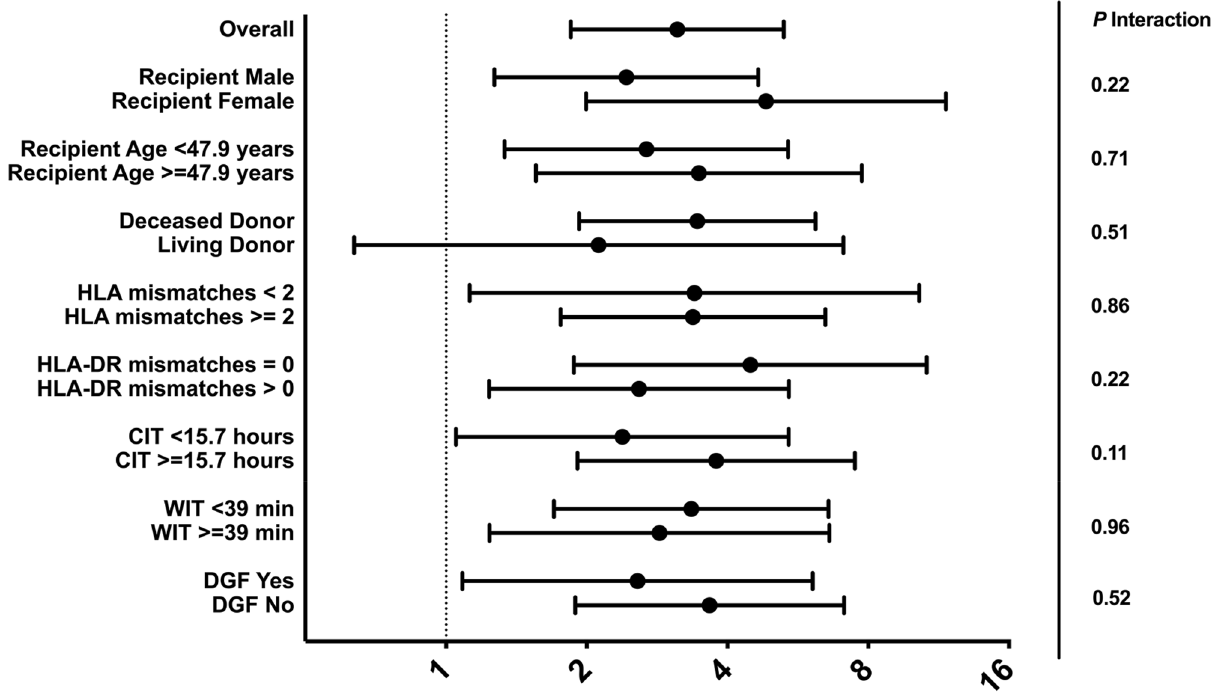
Figure 5. Hazard ratios for the IL-6/IL-6R genetic risk score among subgroups. Forest plot of sub-analyses of the IL-6/IL-6R genetic risk score, demonstrating that the hazard ratios for biopsy-proven rejection were consistent in different subgroups. The only exception was the donor origins of the kidney allografts. The association between the IL-6/IL-6R genetic risk score and rejection was not seen in kidney transplants from living donors. No significant interaction was seen between the IL-6/IL-6R genetic risk score and the different clinical variables of the